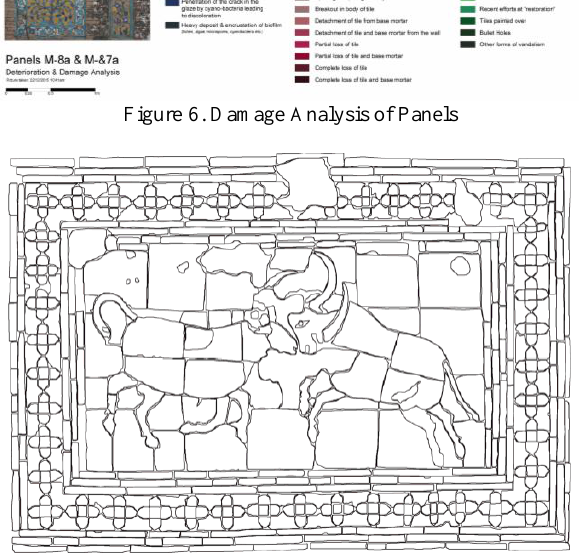
Figure 7. Digitization of a tile mosaic panel